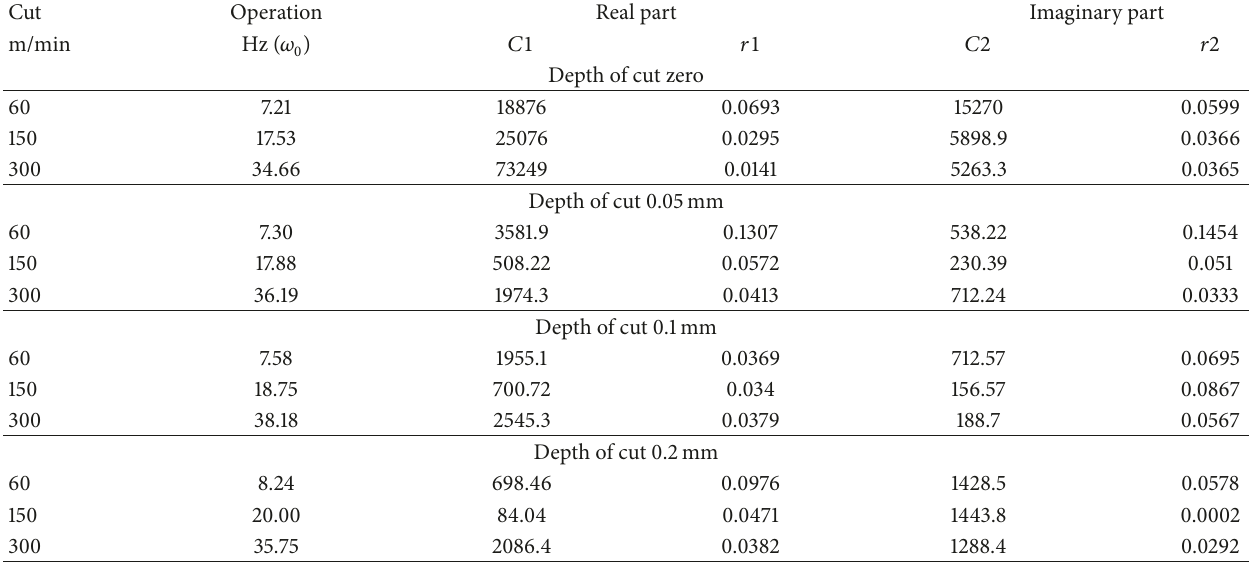
Table 2: Parameter values in relation to the operation speed, obtained with worn insert.